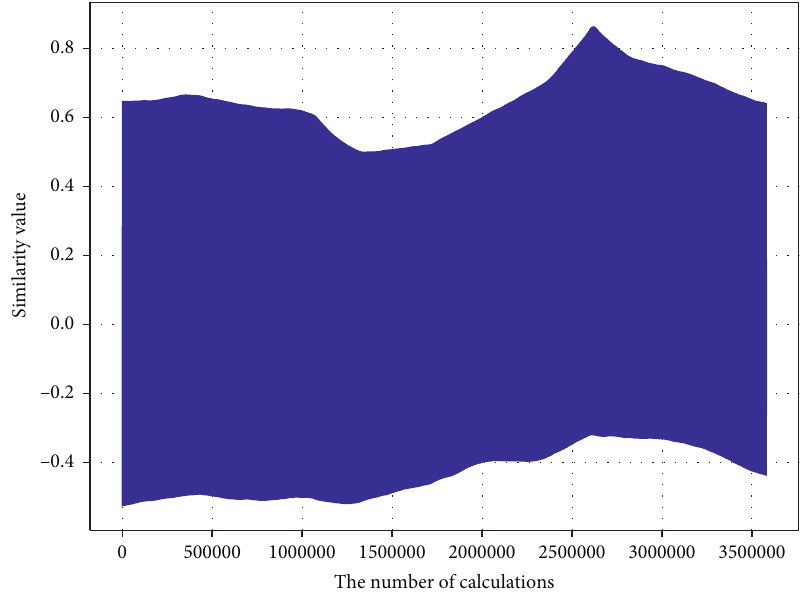
Figure 10: Similarity curve of